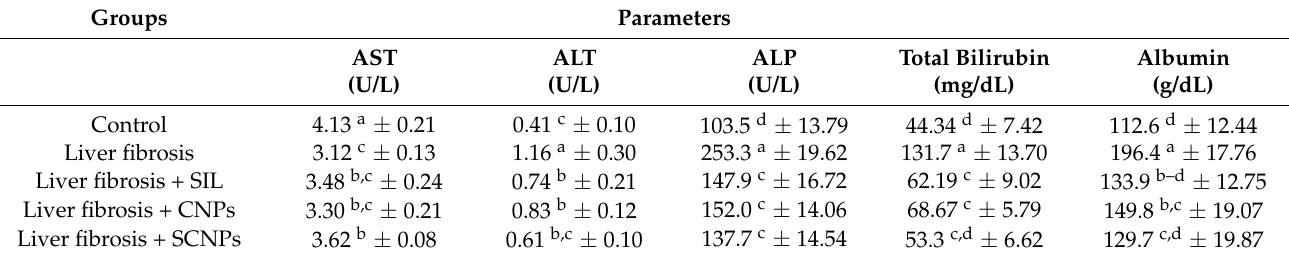
Table 1. Effects of SIL, CNPs, and SCNPs on serum liver function parameters.